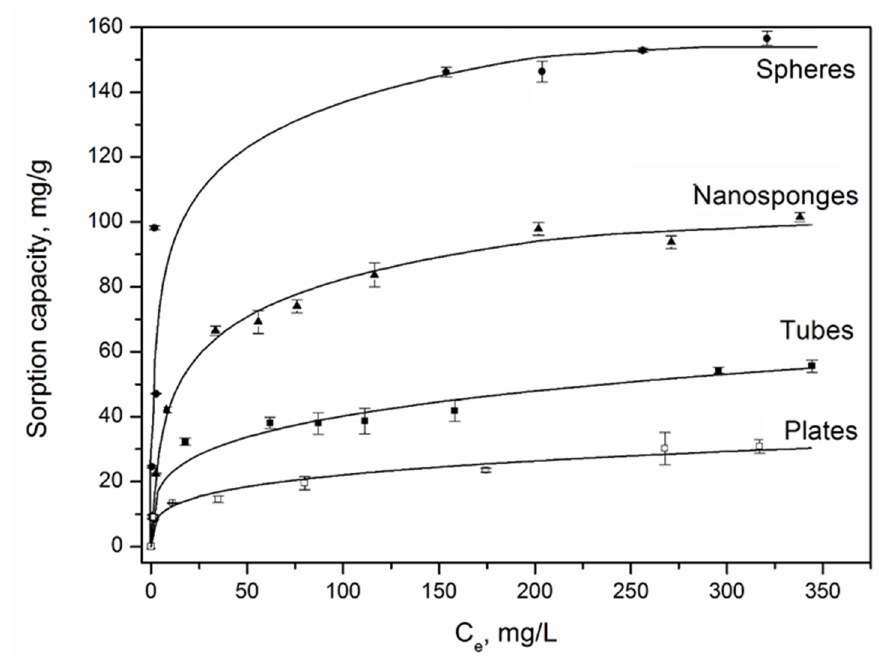
Figure 6. The isotherms of MB sorption by samples with different morphology: ● —spheres; ▲ —nanosponges (Temkin model), ⬛ —nanotubes, □ —plates (Freundlich model).